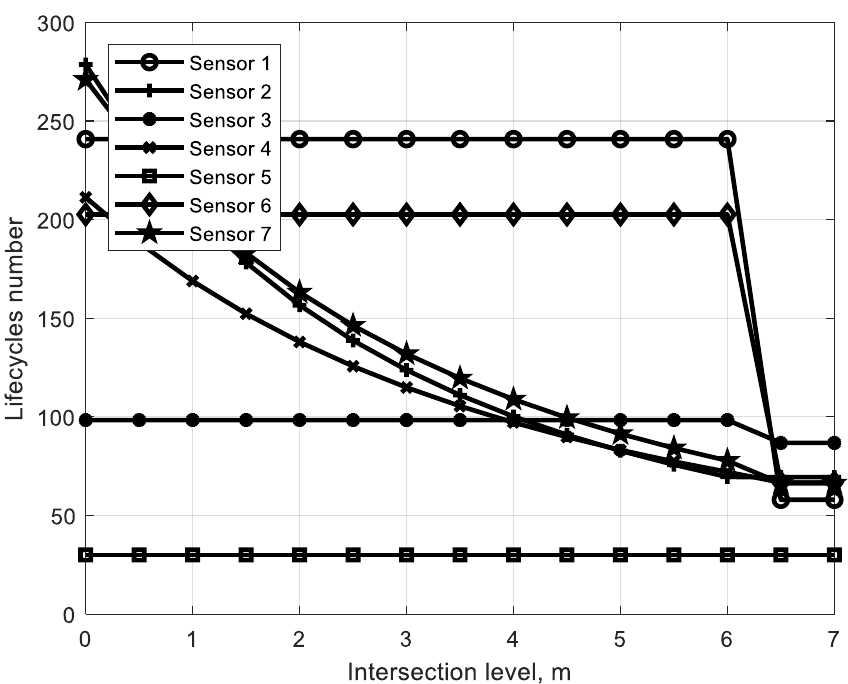
Figure 4. Number of lifecycles of each sensor depending on the level of intersection of the coverage areas.